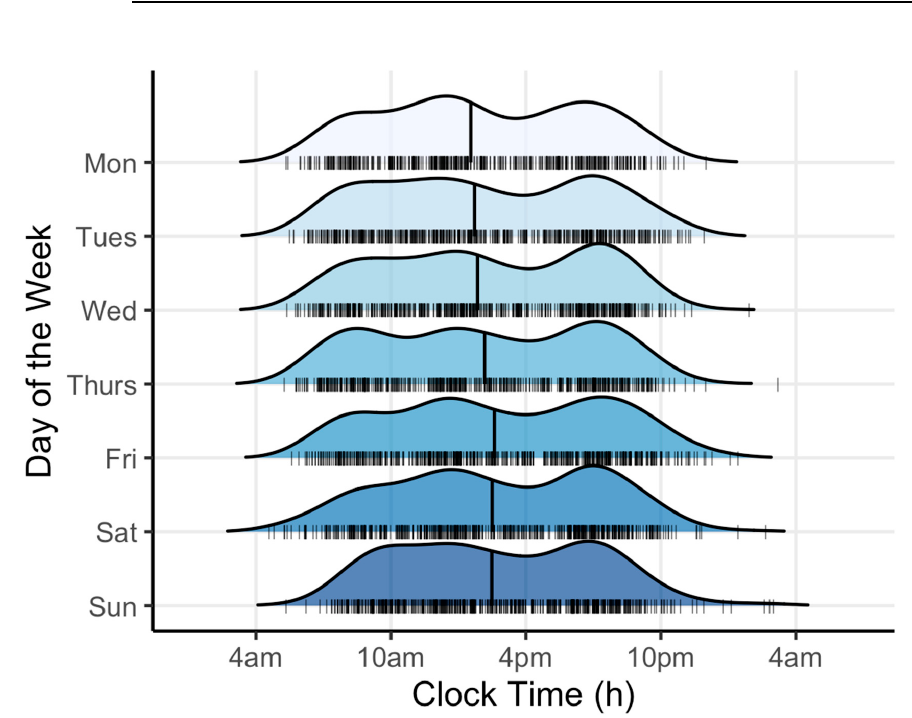
Figure 1. Timing of energy intake by day of the week. Ridgeline plot showing the distribution of energy intake over 24 h for each day of the recording period. Each curve shows the probability density function for energy intake with the area under each curve equal to one. The vertical lines indicate the mid-point of the eating window. The hash marks in each plot correspond to the individual photographs.